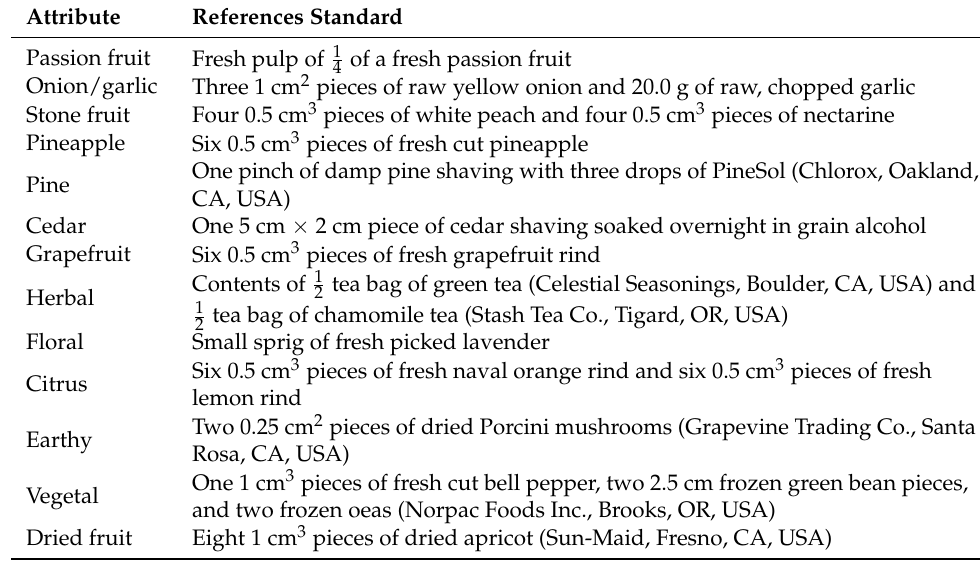
Table 1. Descriptive analysis aroma references and